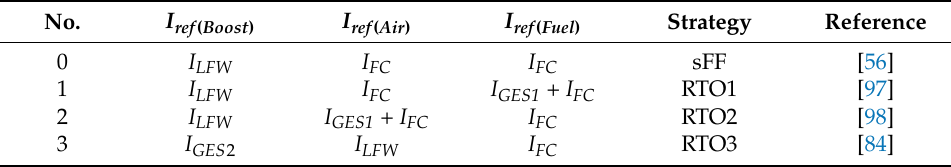
Figure 4. RTO strategy setting block. Table 1. RTO strategies setting.